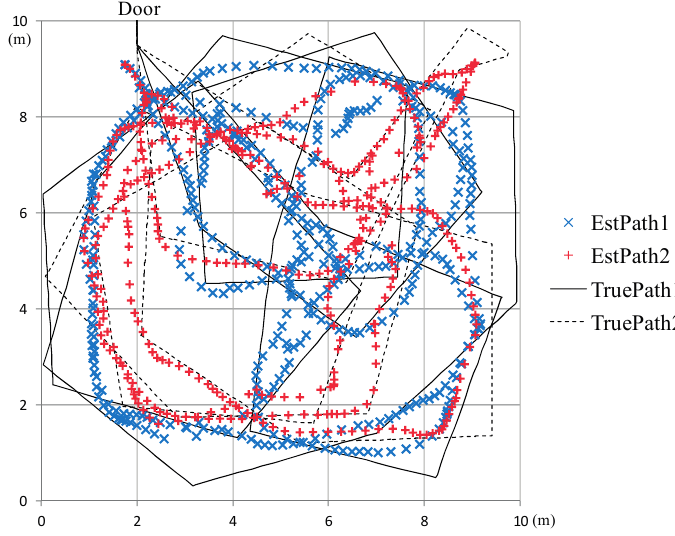
Figure 9. Example of the path estimation